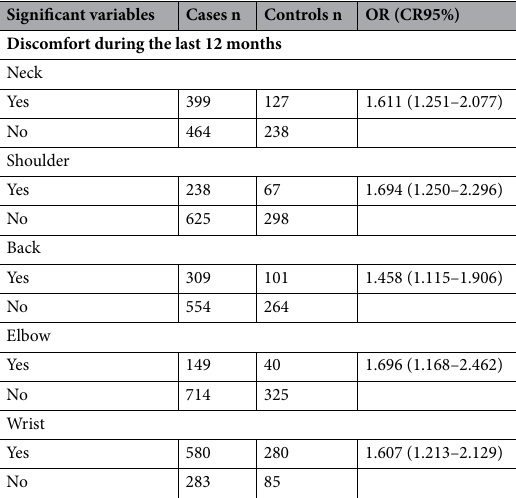
Table 3. Bivariate analysis. University students experiencing discomfort in the last 12 months with and without dependency on the smartphone.